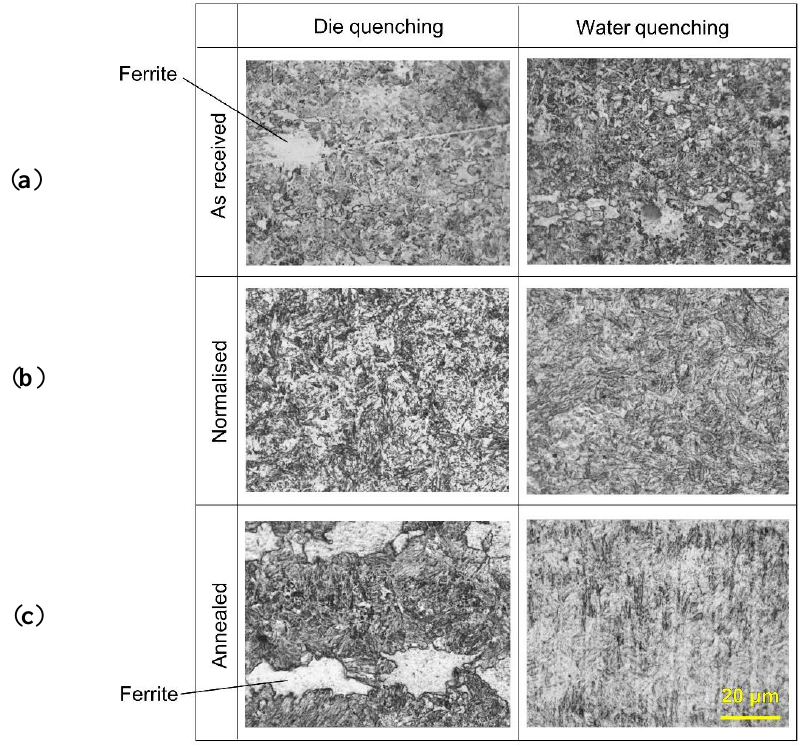
Figure 12. Microstructures of die- and water-quenched sheet from ( a ) as-received, ( b ) normalised and ( c ) annealed sheets for v = 275 °C/s and t = 0 s.